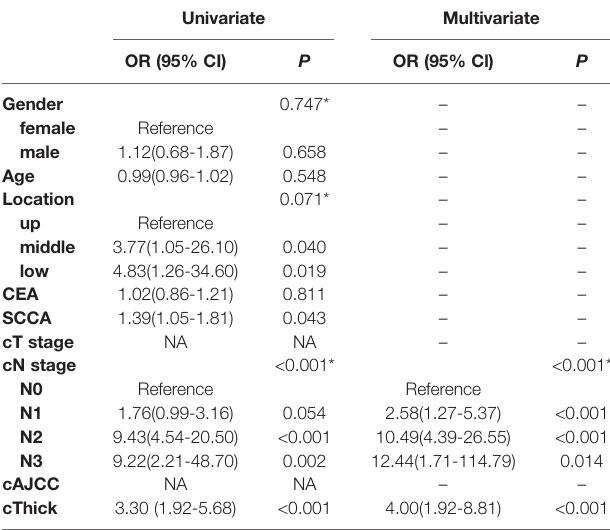
TABLE 2 | Univariate and Multivariate analysis to identify signi fi cant factors for LVI. Univariate